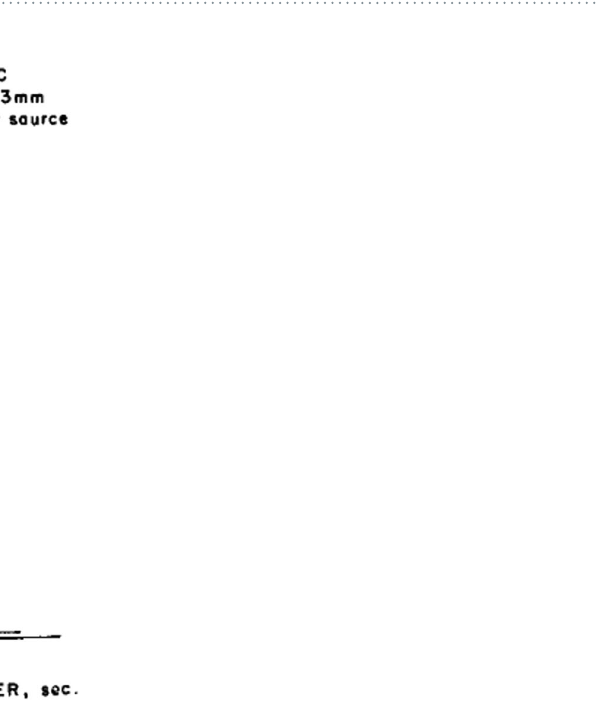
Figure 3. Temperature spikes in dry kaolinite as the water front arrives at two different positions along a soil sample 3 .